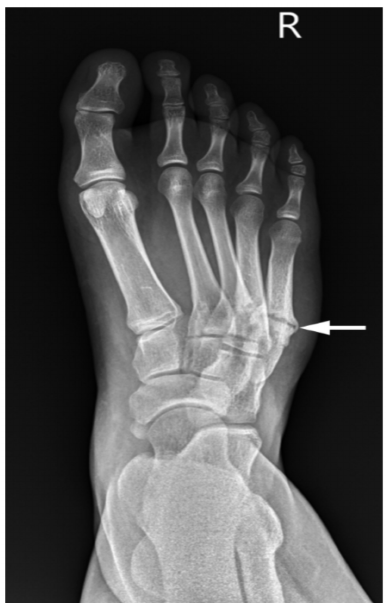
Figure 5. Radiographic features of Stage 4 MSP in the foot. Severe varus deformity of the foot in a 14-year old boy with Type IV hemiplegia, GMFCS II. There are healing fractures of the 4th and 5th metatarsals, from severe chronic overloading. Management to date has been injections of BoNT-A to the gastrocsoleus and tibialis